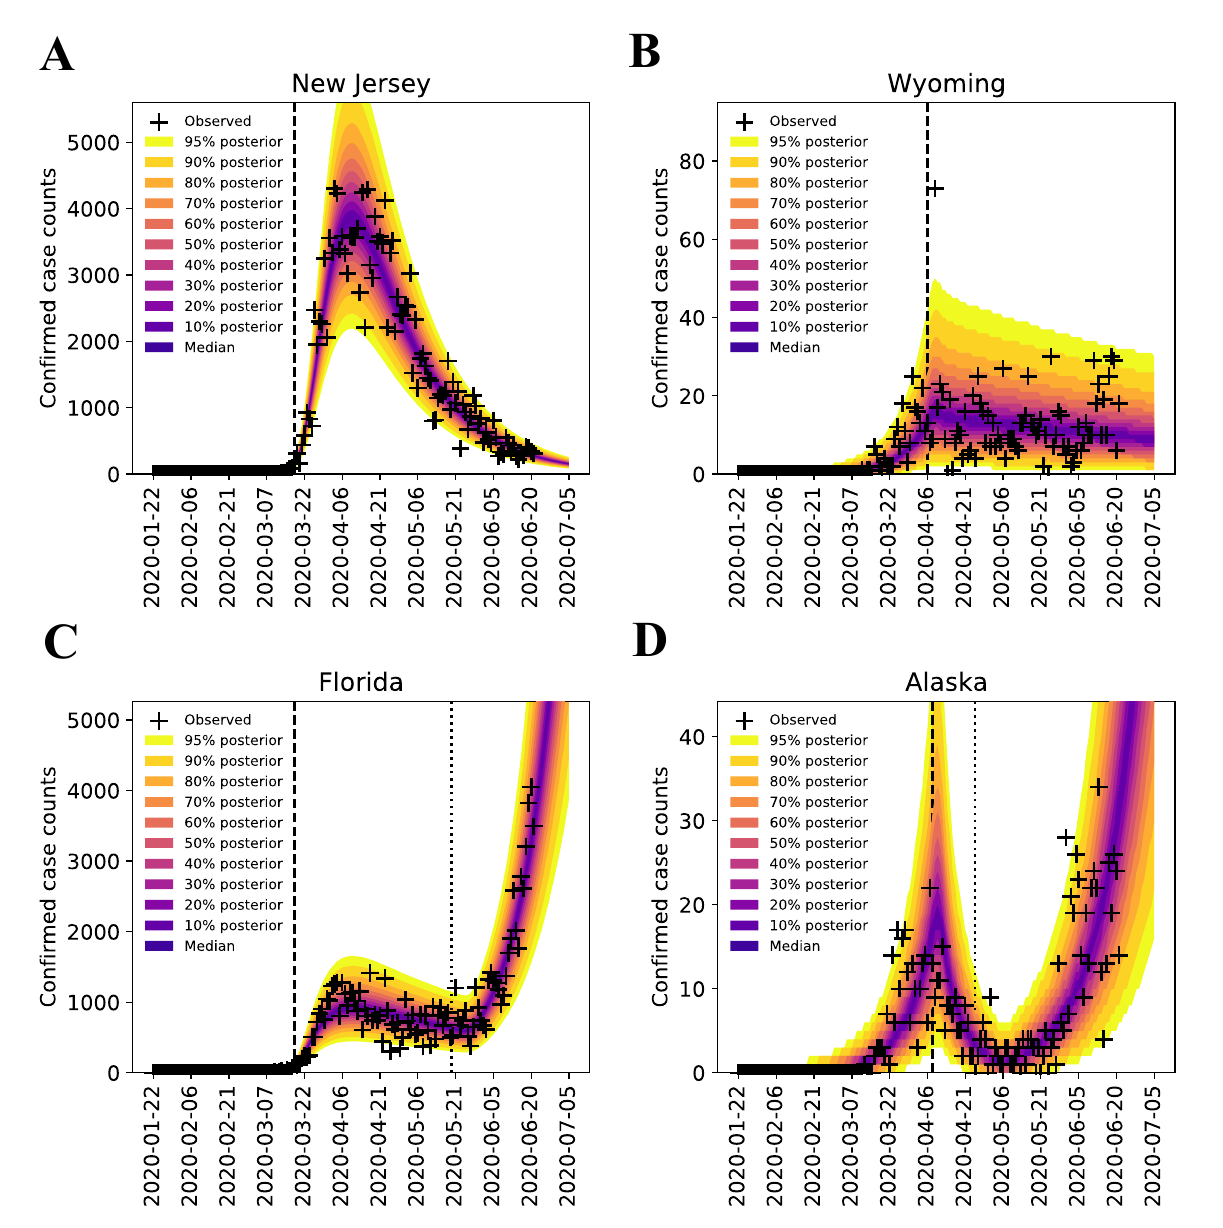
Figure 1. Bayesian predictive inferences for daily confirmed case counts of COVID-19 in ( A ) New Jersey ( B ) Wyoming ( C ) Florida ( D ) Alaska, from 21 January to 21 June 2020 (inclusive dates). The compartmental model [22] accounts for an initial social distancing period followed by n additional periods. We considered n = 0, 1 and 2 and selected the best n using the model selection procedure of Lin et al. [22]. Plus signs indicate daily case reports. The shaded region indicates the prediction uncertainty and inferred noise in the detection of new cases. The color-coded bands within the shaded region indicate the median and different credible intervals (e.g., the dark purple band corresponds to the median, the band with lightest shade of yellow corresponds to the 95% credible interval, and gradations of color between these two extremes correspond to different credible intervals, as indicated in the legend). In each panel, the vertical broken line indicates the onset time of the first social-distancing period. For states with n = 1 (Alaska and Florida), there is an additional broken line, which indicates the onset time of the second social-distancing period. The model was used to make forecasts of new case detection for 14 days after 21 June 2020. The last prediction date